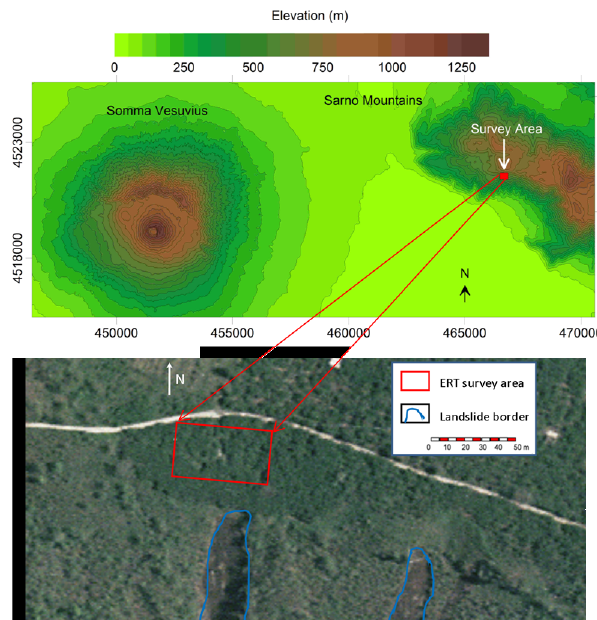
Fig. 2. Geoelectrical survey area (red rectangle) on an orthophoto- graph of the northern slope of Mt Pizzo d’Alvano (Salerno, Italy). Blue lines indicate the initial detachment areas of two landslides that occurred on 5 and 6 May